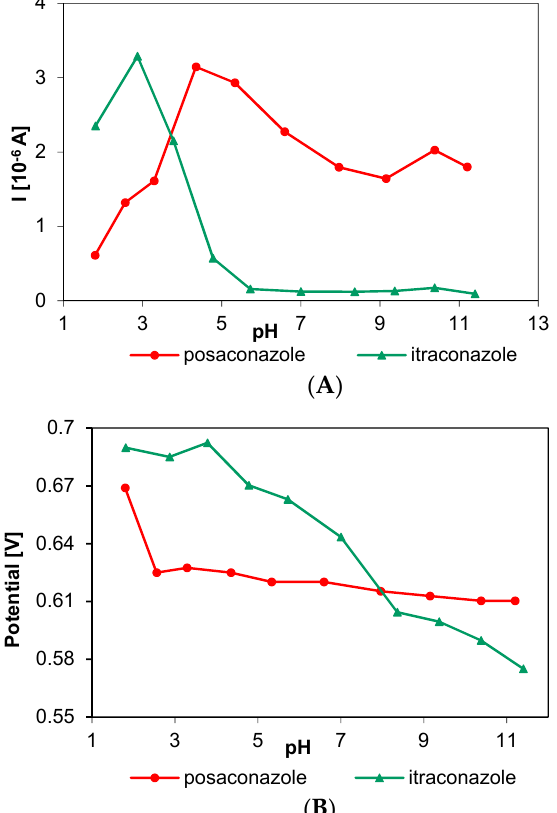
Figure 4. Effect of pH on selected biocides: ( A ) anodic peak current and ( B ) anodic peak potential. The highest values of itraconazole oxidation peak were obtained in the B-R buffer with pH = 2.87, and of posaconazole in the solution with pH = 4.35. As the pH of the electrolyte increased, the